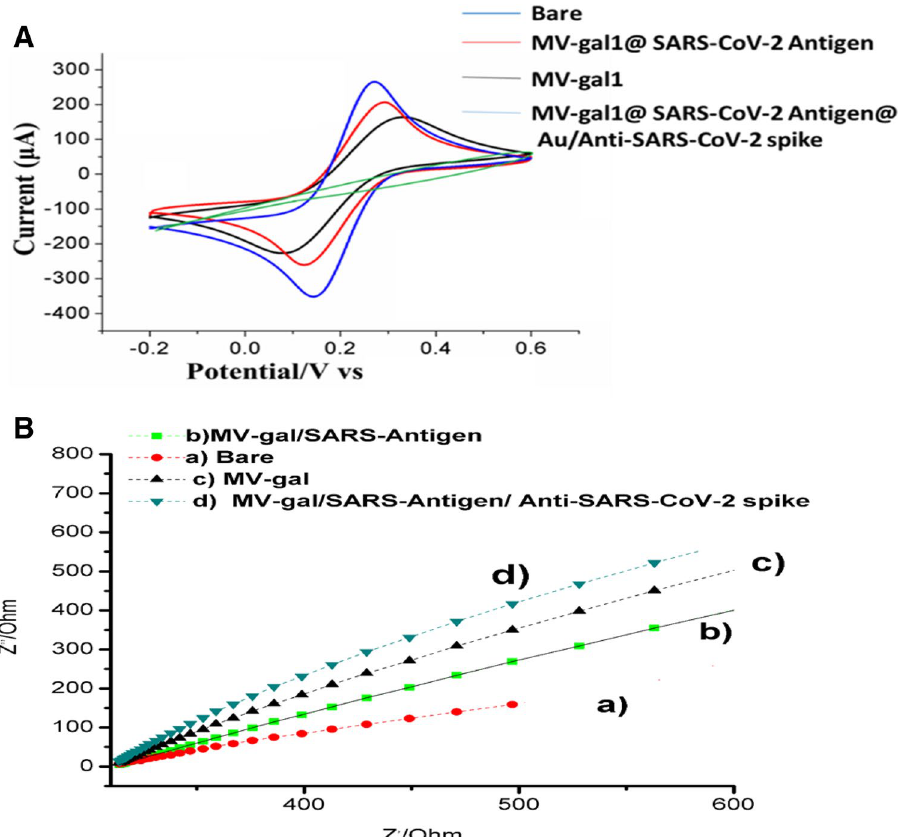
Figure 2. ( A , B ) DPV and EIS behaviors about and EIS images about fabrication of MV-gal1@SARS-CoV-2 Antigen@Au/Anti-SARS-CoV-2 spike on the SCPE-GNP. Data recorded at the scan rate 50 mV s −1 in phosphate buffer (pH 7.4) containing 1 mM [Fe(CN) 6 ] −3/−4